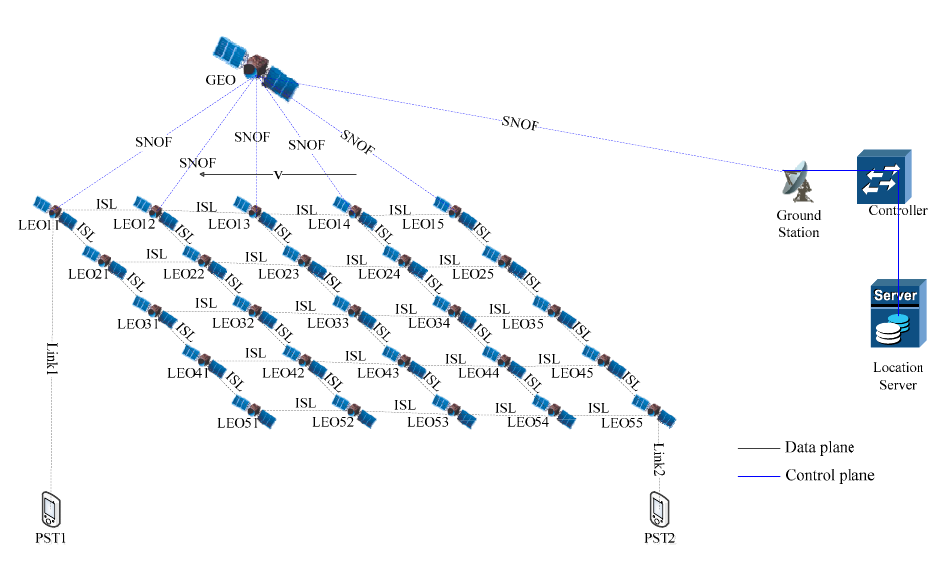
Figure 2. Multi-QoS routing model.